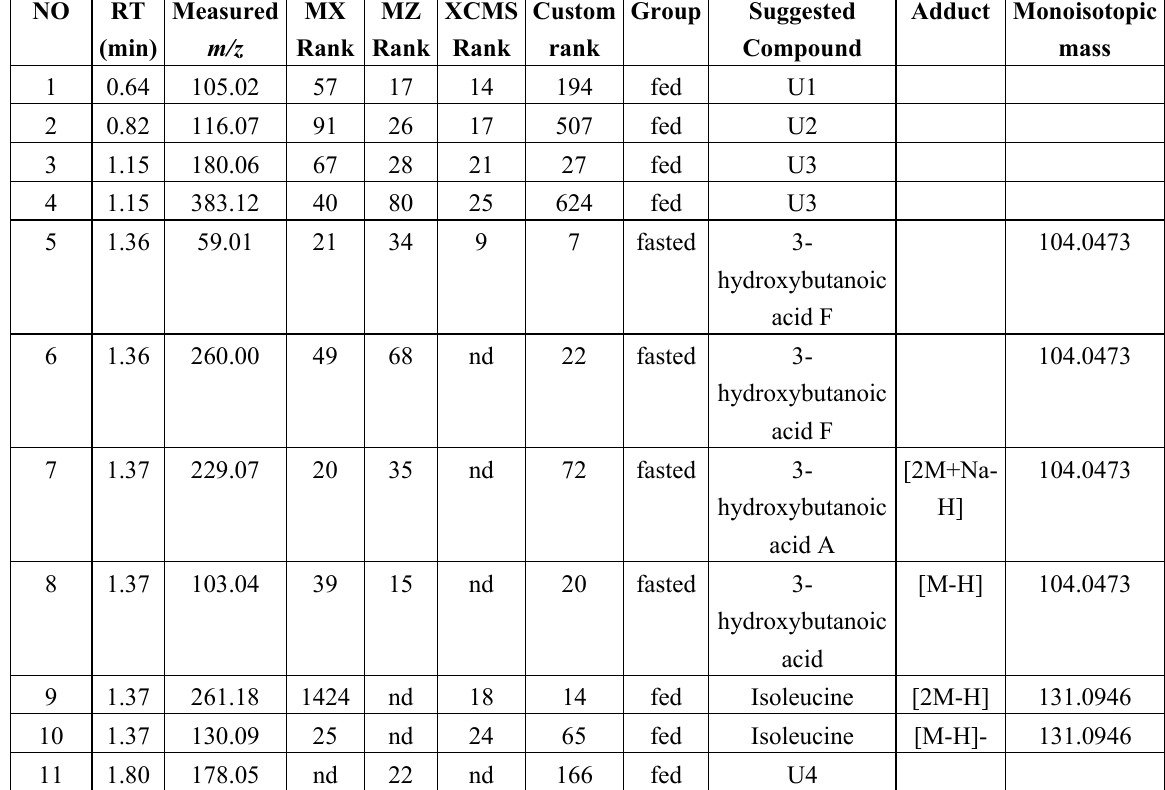
Table 1. Retention times and measured masses of the markers obtained from MarkerLynx, MZmine, XCMS and custom data processing of negative mode data that contributed most to the separation of samples in fasted and fed